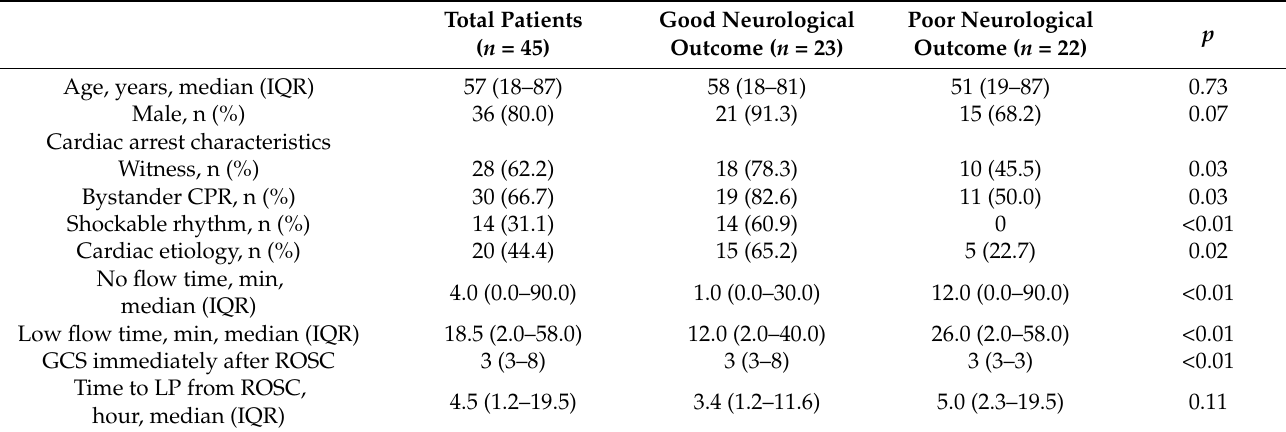
Figure 1. Flow diagram of patients included in this study. Table 1. Baseline demographics and characteristics of 44